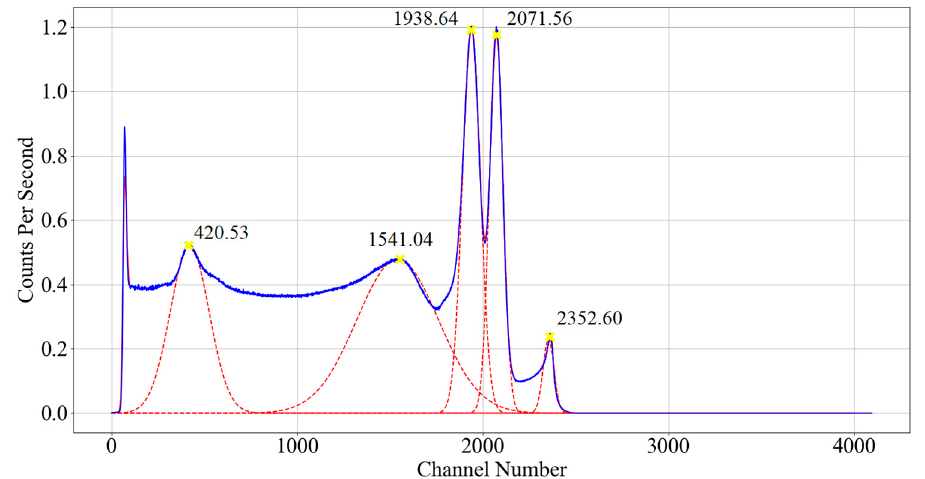
Figure 16. The spectrum of theCo-60 sealed source with the background removed taken at zoom level 1, blue trace: raw channel data, solid red trace: 20 sample moving average, dashed red trace: Gaussian fit around peaks (capture time: 19.76 h, for an average of 1002.85 CPS).